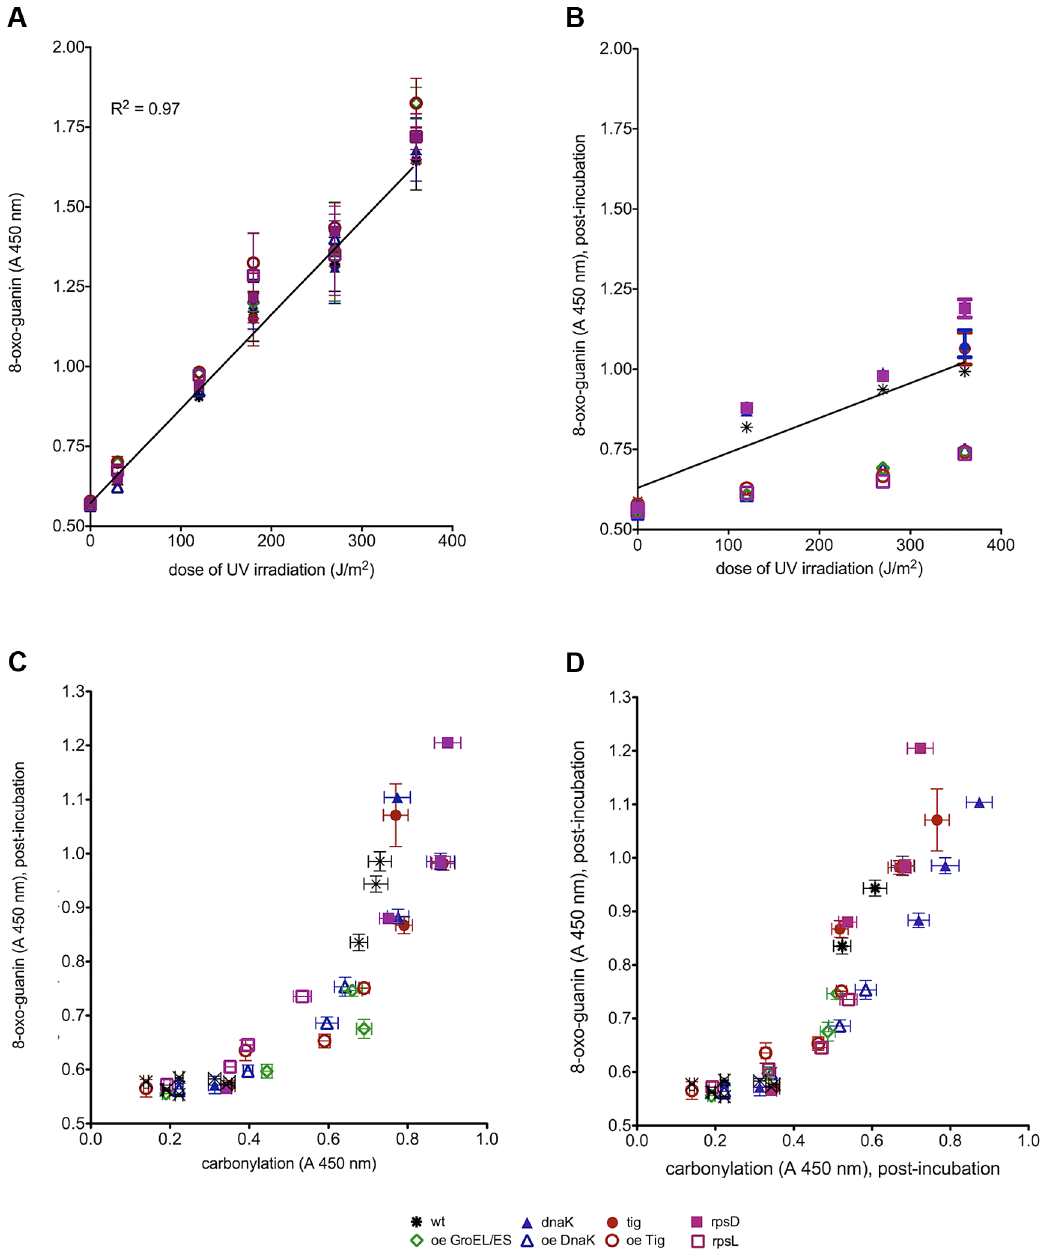
Figure 5. Protein damage reduces the efficiency of DNA repair. The level of 8-oxo-guanine in DNA (a) immediately after irradiation and (b) at the end of the recovery period when it increases differently with the UVC radiation depending on the fidelity of protein biosynthesis and chaperone activity. (c) 8-oxo-guanine level correlates with the protein carbonylation level immediately after irradiation. (d) 8-oxo-guanine level after post- irradiation incubation correlates with protein carbonylation. 8-oxo-guanine and protein carbonylation levels prior to irradiation are labeled with an X. The results are given as mean of 2 measurements, each in triplicate. Error bars represent the standard deviation. R 2 value of the linear fit is indicated in panel (a). ‘‘Oe’’ stands for over-expression.